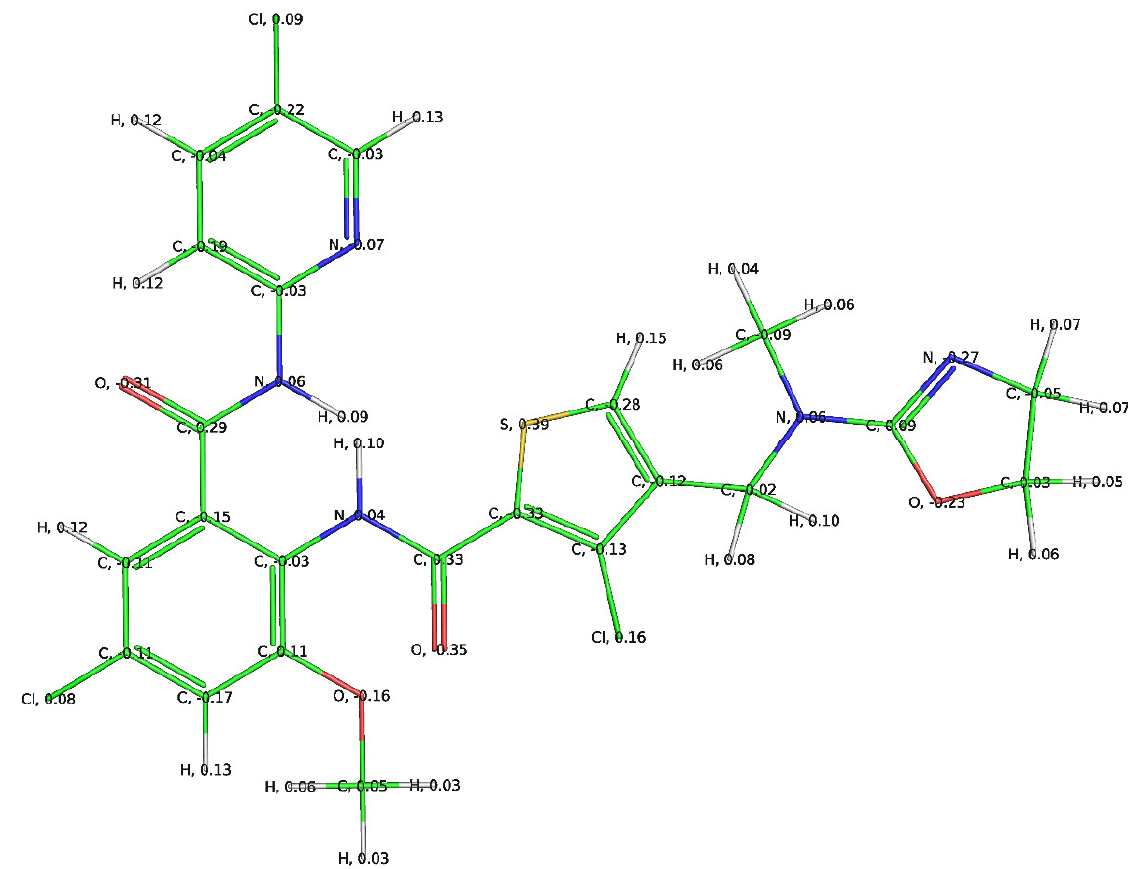
Figure 7. Compound 1 with partial charges in the active site of factor Xa (charges assigned using PM3 available in MOPAC2016 (http://openmopac.net)).